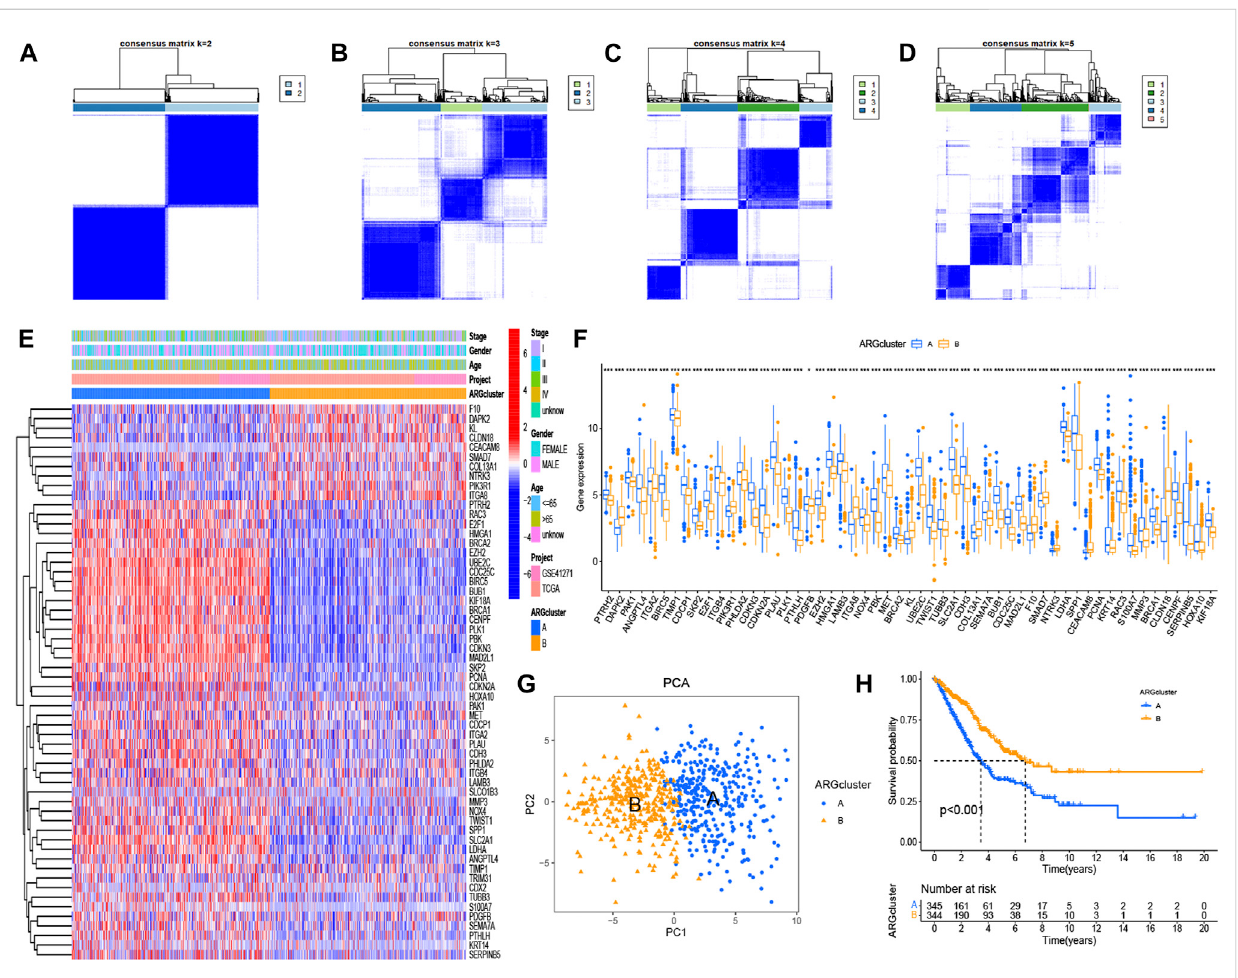
FIGURE 2 ConsensusclusteringofARGsandsurvivalanalysisusingK-Mcurves. (A – D) Consensusmatricesof58signi fi cantARGs(k=2 – 5). (E,F) Heatmapand histogramofthe58ARGsexpression. (G) PCAfortheexpressionpro fi lesofdifferentpatterns. (H) Comparisonofsurvivalpossibilityintwosubgroups.The signi fi cance criteria were set as p -value < 0.05. * p < 0.05, ** p < 0.01, and *** p <